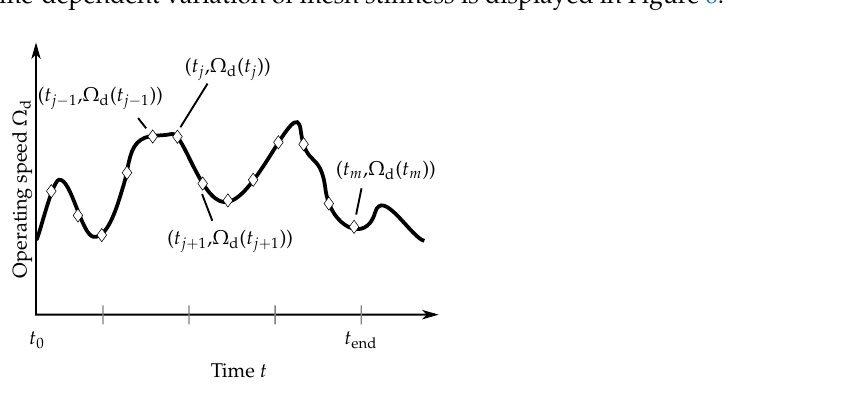
Figure 5. The operating speed Ω d ( t ) during a considered time range is defined at m discrete time steps t j